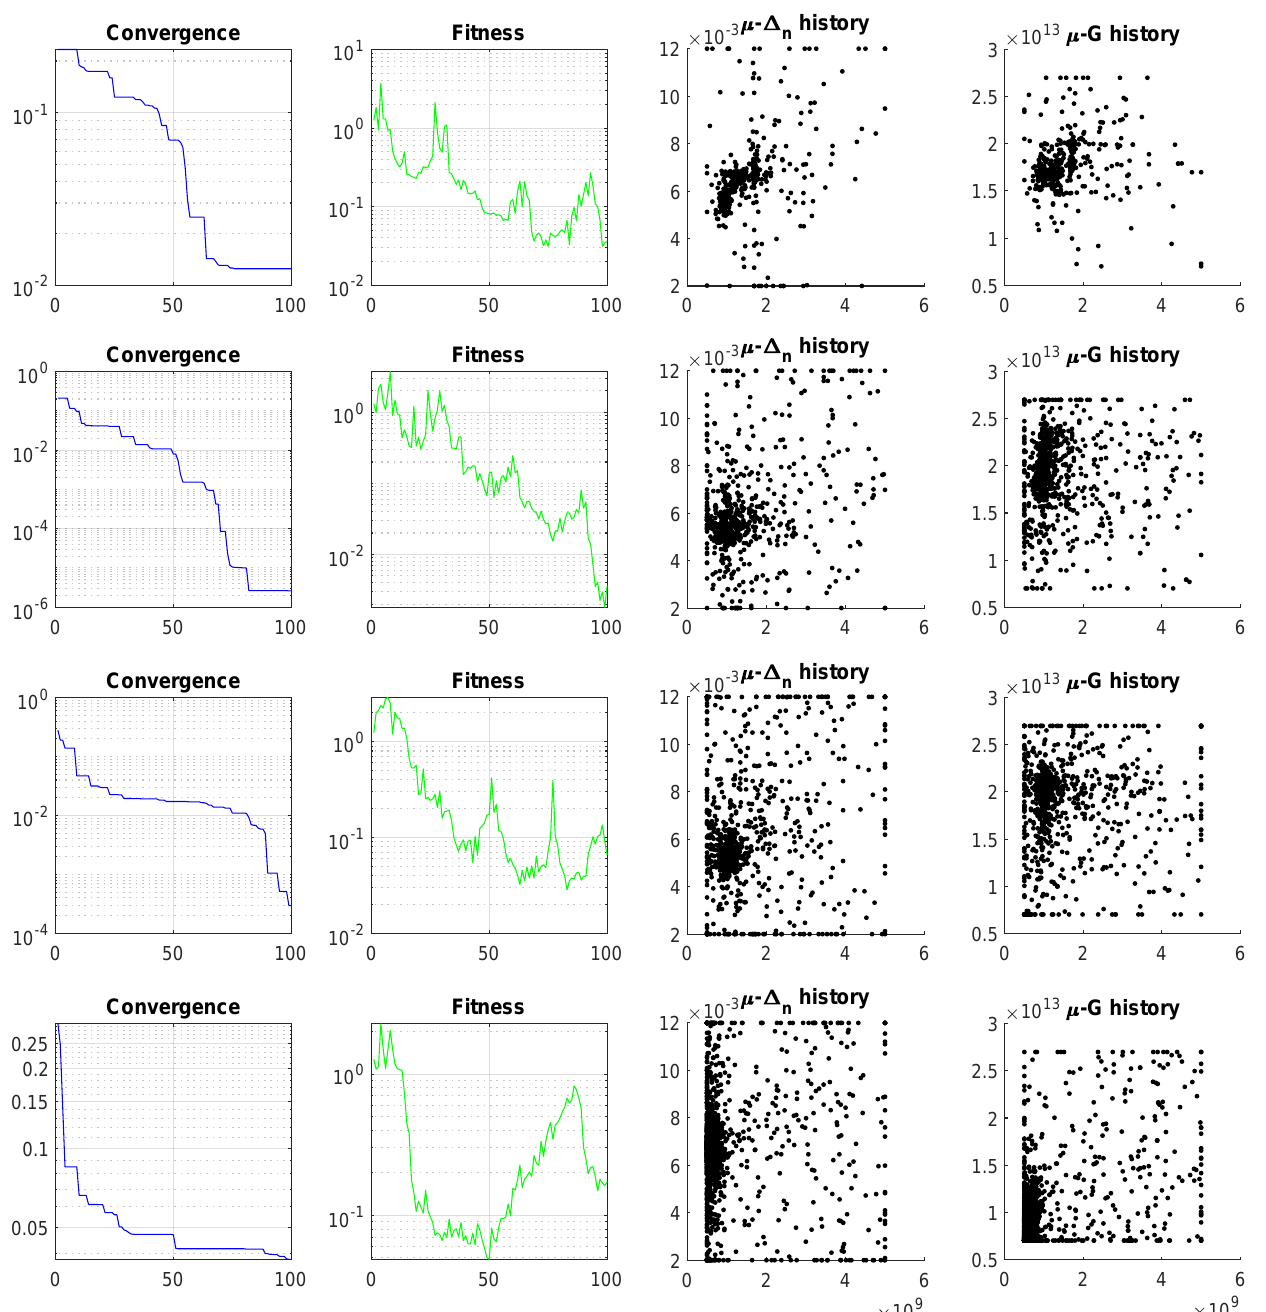
Figure A1. Blue plot is the convergence of the PSO algorithm (minimum value of f ( x ) ), green plot is the fitness of the population (mean value of f ( x ) ) both plots horizontal axes are the PSO iterations. The two scatter plots represent different planes in the optimization variable space, µ − ∆ n and µ − G . The axes are in the units of the corresponding variable, Pa or adimentional for ∆ n . Swarm Population from top to bottom: 8–16–24–32. Objective function f ( x ) resolution: 8